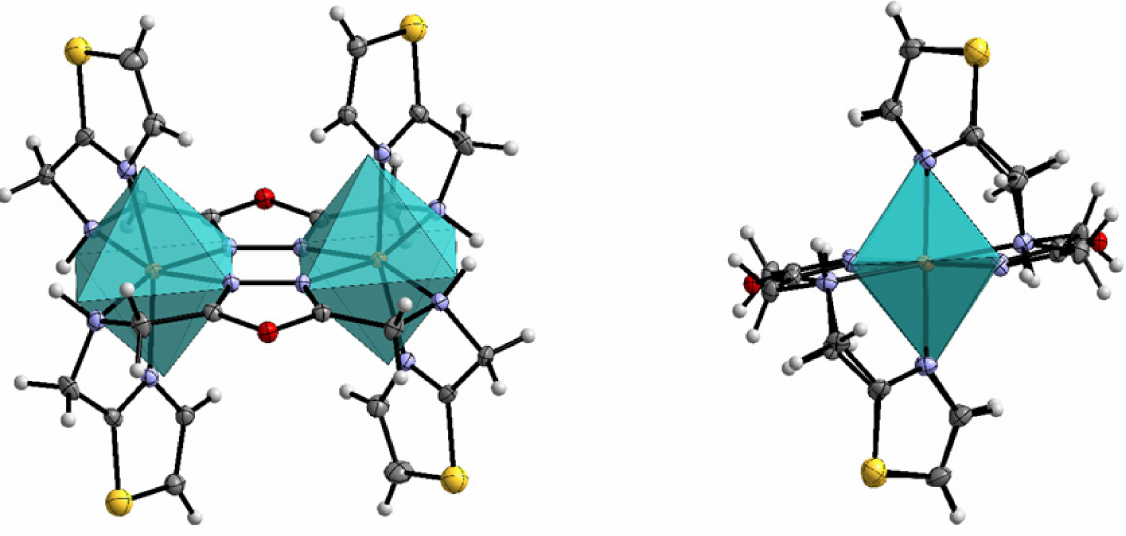
Figure 2. ( Left ): Molecular structure of 1 and its ideal coordination octahedron with front view and view onto the Fe-Fe axis ( right ), calculated with SHAPE [55]. Scheme: dark grey—C, grey—H, violet—N, red—O, yellow—S, orange—Fe. ORTEP representation with atomic displacement parame- ters set to 50%